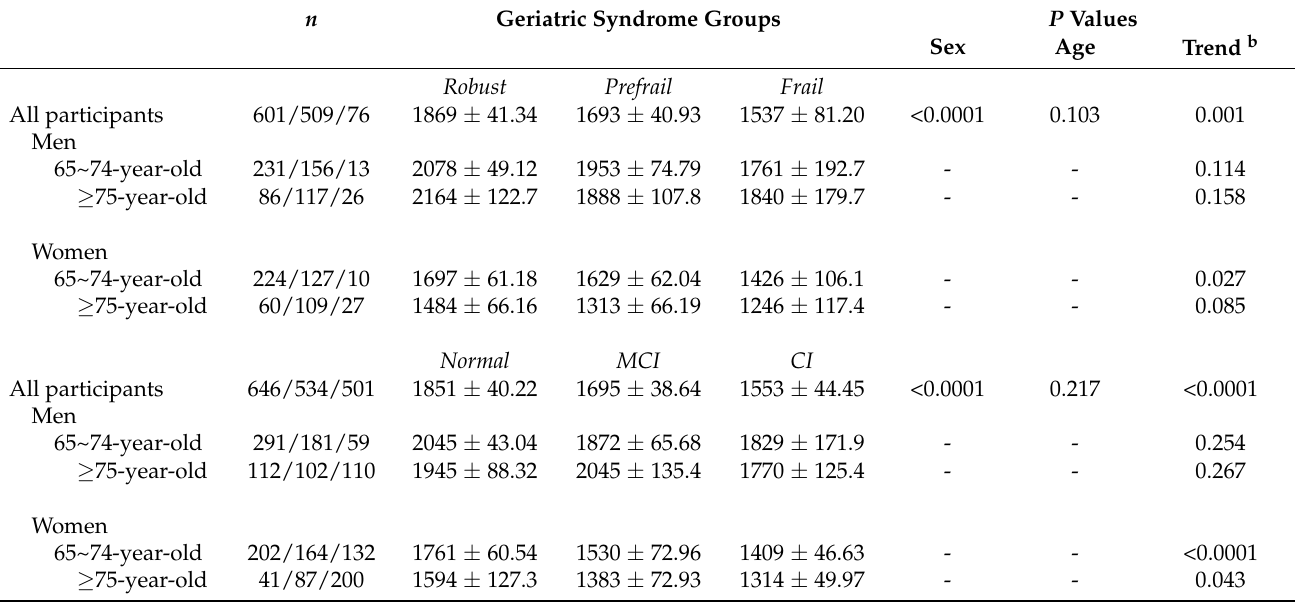
Table 1. Energy intakes by geriatric syndrome groups in all participants and in sex–age subgroups, using 2014–2017 NAHSIT data a